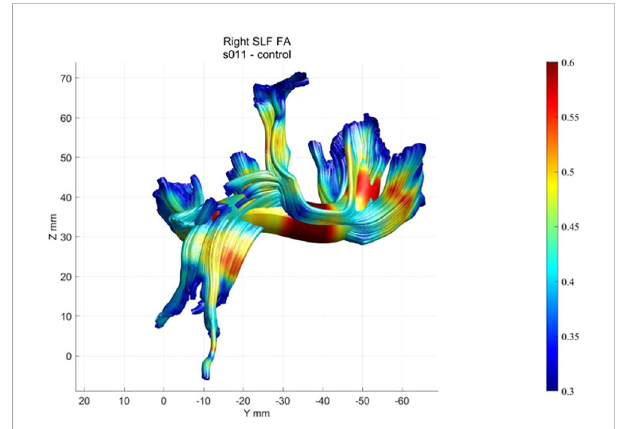
FIGURE 4 Example of a healthy participant ’ s FA pro fi le of the right